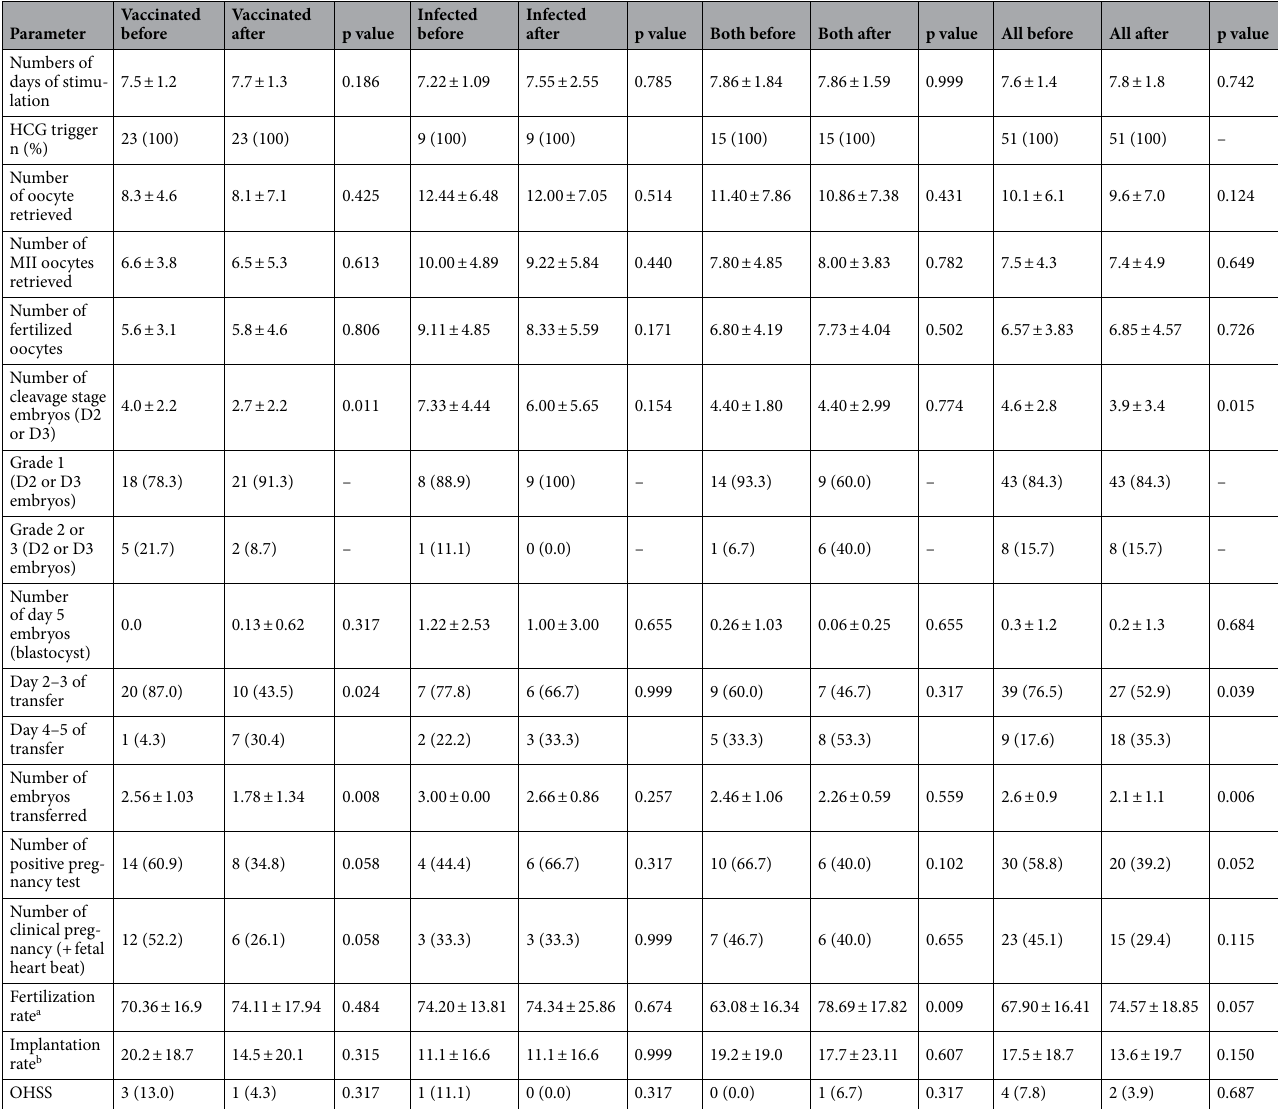
Table 4:. IVF parameters outcome before and after vaccine/infection. SD standard deviation, V vaccinated, I infected, r pre, s post, C control, T total, FHB fetal heartbeat, OHSS ovarian hyper-stimulation syndrome. a Fertilization rate is defined as the percentage of fertilized oocytes from the collected oocytes. b Implantation rate is calculated as the number of gestational sacs observed per number of embryos